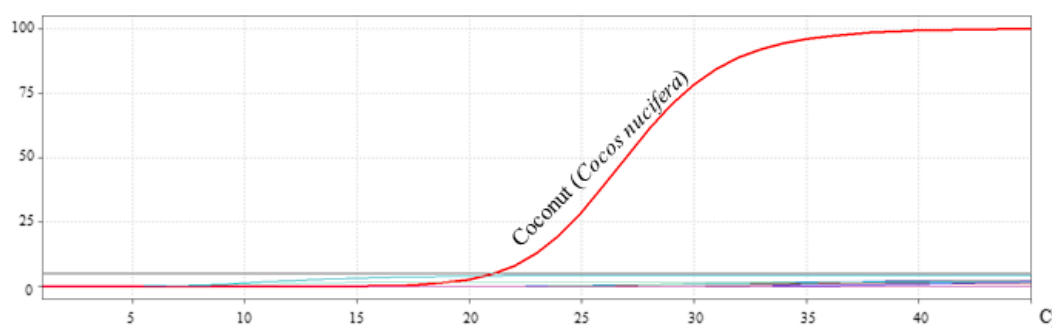
Figure 3. Specificity test of the primer / probe system for coconut identification. No amplification was detected with species other than coconut.